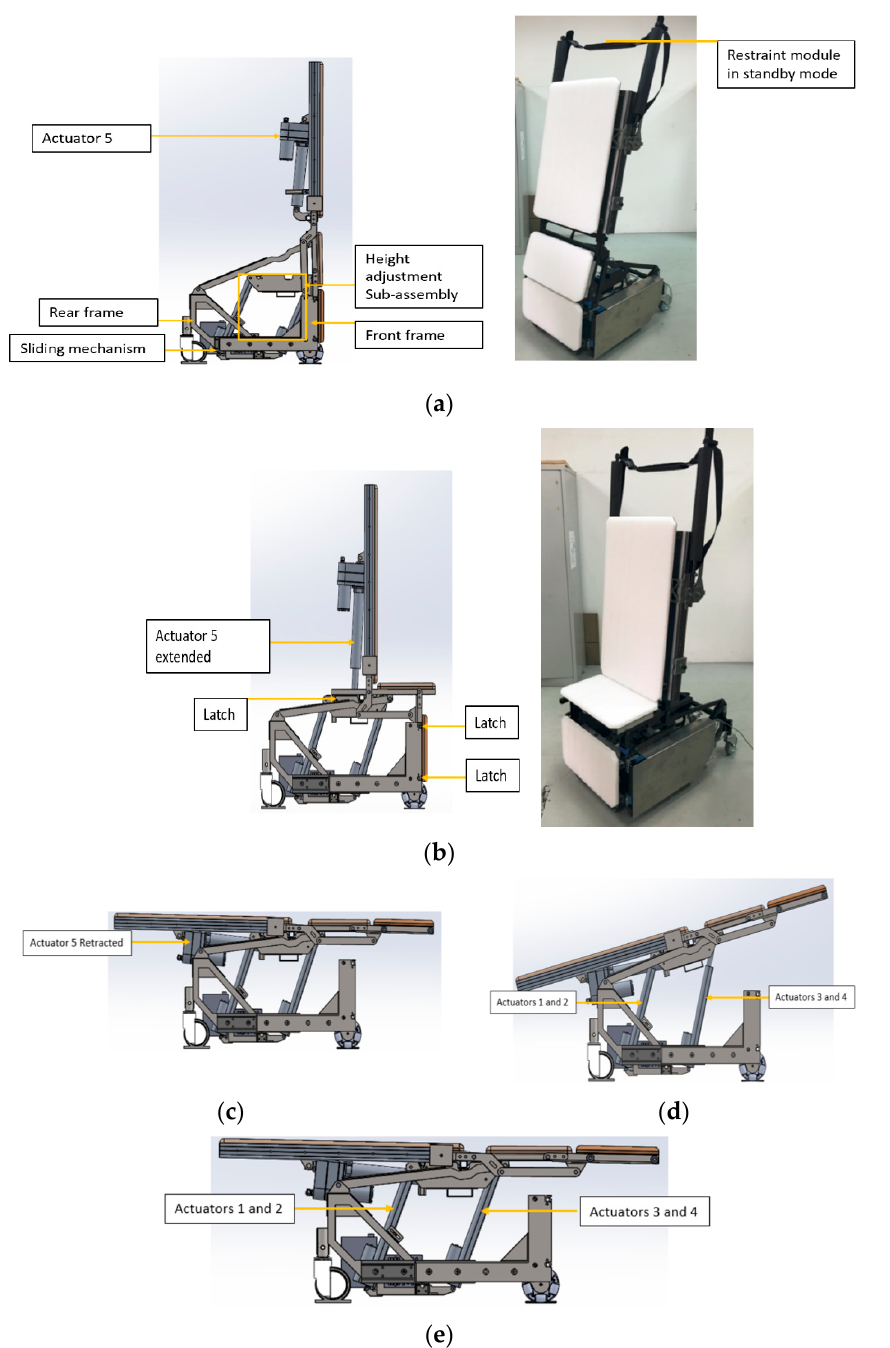
Figure 3. Multi-position of IMOVE-I. ( a ) Resting erect standing position, photo on the right. ( b ) Sitting position, photo on right. ( c ) Supine position. ( d ) Trendelenburg position. ( e ) Height adjustment.